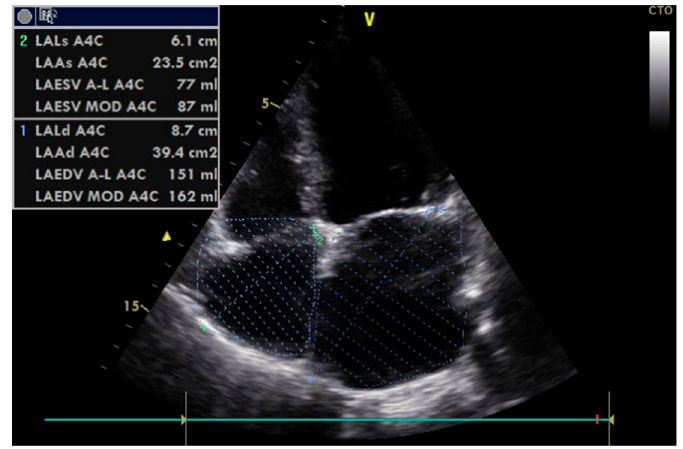
Figure 7. Echocardiographic measurement of left (and right) atrial volume by disks method. V: specific echocardiographic parameter (it does not mean a measurement data).